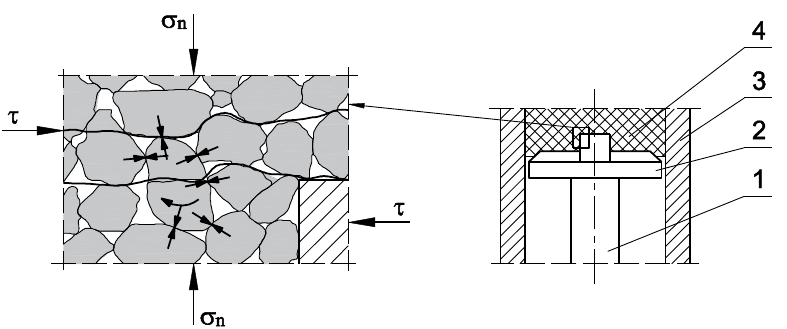
Figure 4. Schematic diagram of coal grain arrangement inside the testing device (fine coal versus disc-bar assembly) and interpretation of interaction between the particulate coal and the bar within shear zone, where: 1 — driving shaft, 2 — disc-bar assembly, 3 — cylindrical container, 4 — particulate coal-abradant (feed).